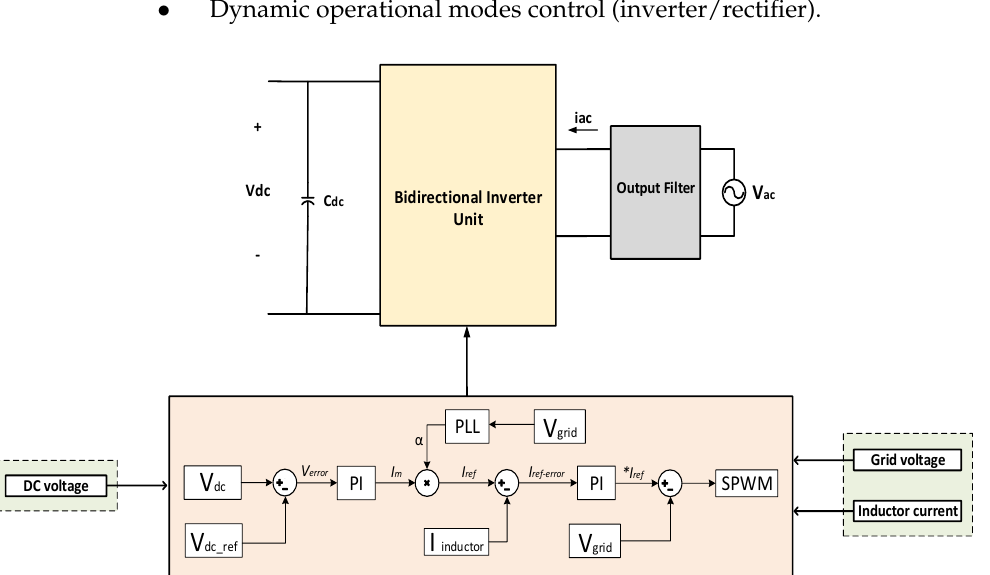
Figure 14. General configuration of the bidirectional inverter control